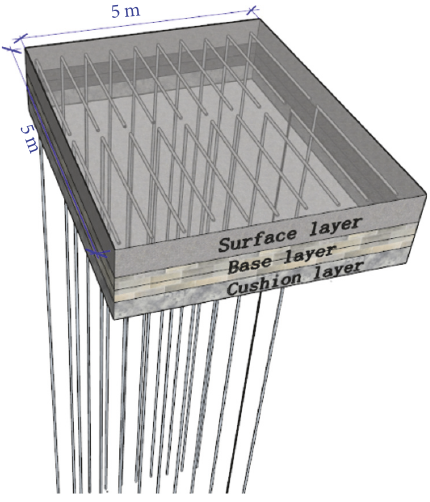
Figure 2: Heat pipe snow melting